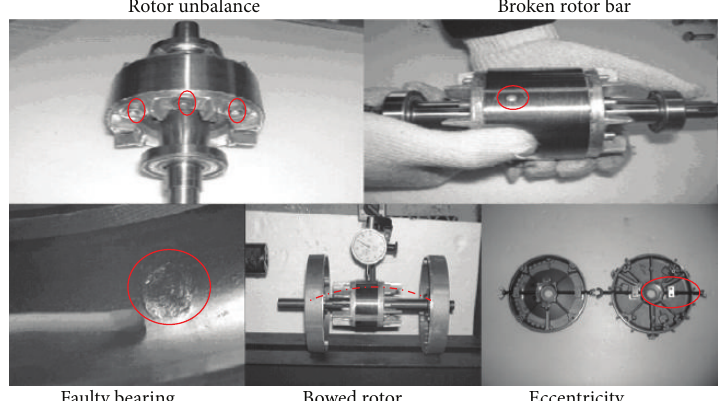
Figure 5: Typical induction motor faults.